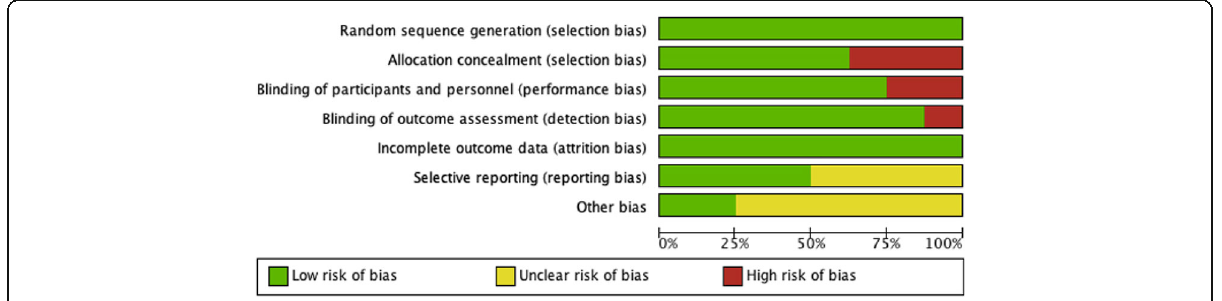
Fig. 2 Risk of bias assessment graph for randomized controlled